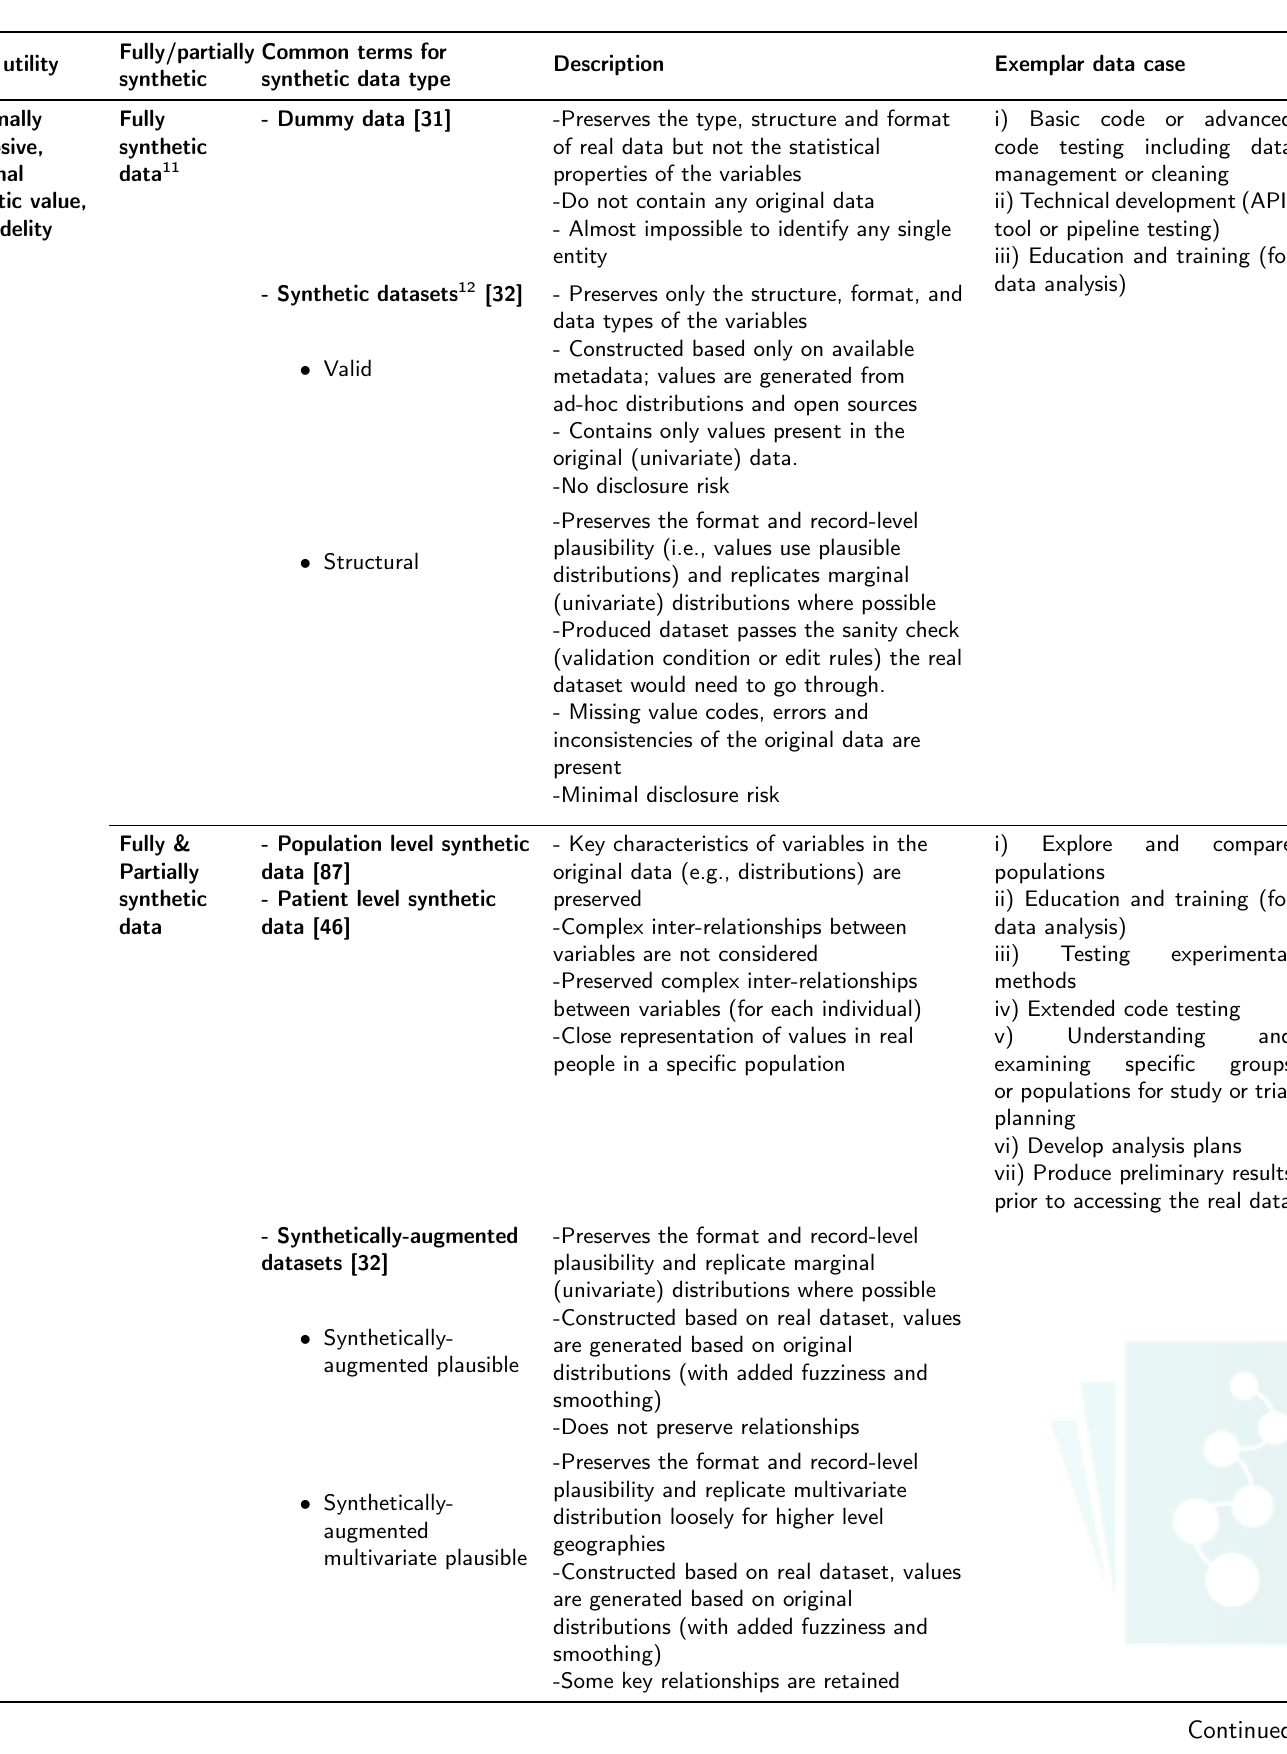
Supplementary Table 1: Existing categorisations of synthetic data currently used in the literature. A simplified categorisation is proposed in Table 1 of the main